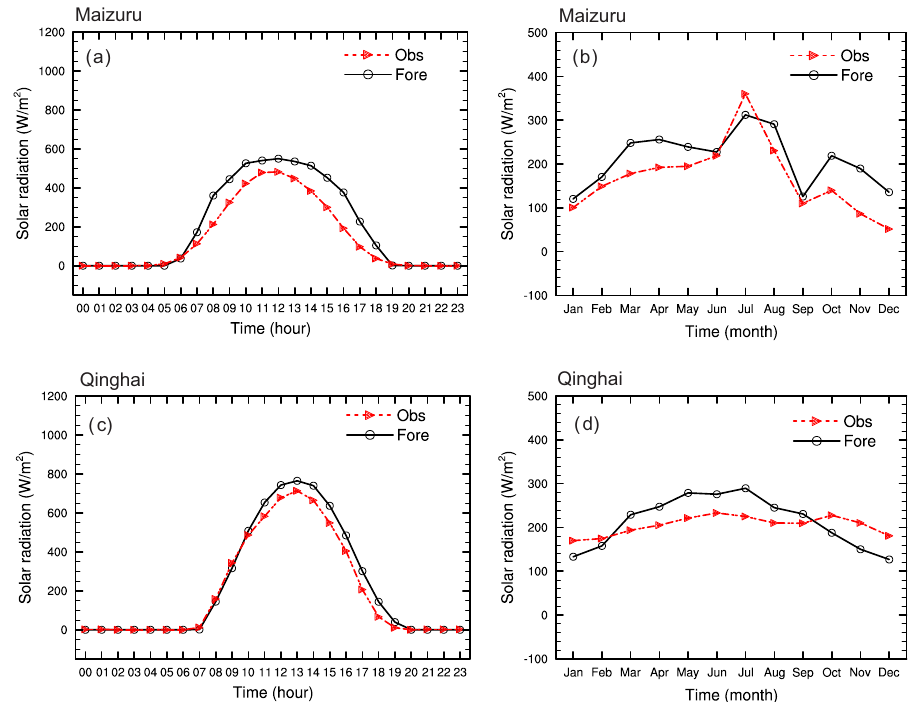
Figure 5. The 12-month mean solar radiation (W/m 2 ) series from 12:00 a.m. to 11:00 p.m. ( a ) and the monthly averaged series of 2018 solar radiation ( b ) for the Maizuru site; ( c ) and ( d ) display similar results but for the Qinghai site in 2017. Note that the time mentioned is local time. The marked black and red lines stand for forecasts and the corresponding observations,